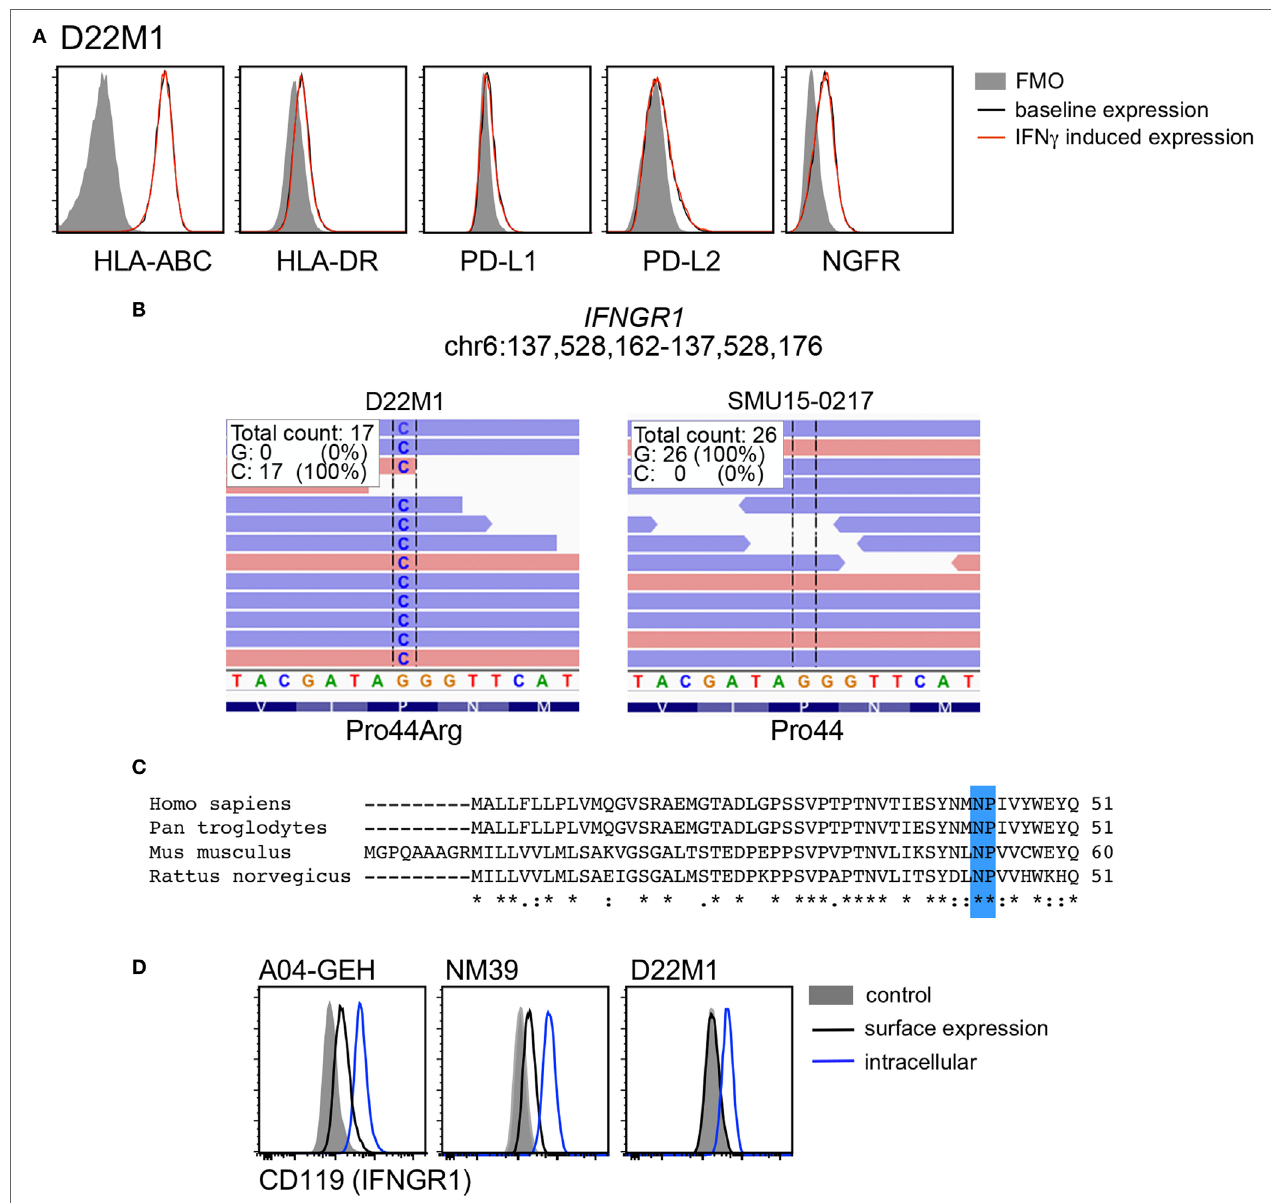
FigUre 6 | Analysis of interferon gamma receptor 1 (IFNGR1) expression in the D22M1 cell line. (a) Representative histograms of cell surface expression of HLA-ABC, HLA-DR, PD-L1, PD-L2, and nerve growth factor receptor (NGFR) on D22M1 cells. Baseline expression is shown in black, interferon- γ (IFN γ )-induced expression in red, and fluorescence minus one (FMO) controls as shaded histograms. (B) Whole exome sequencing analysis showing Pro44Arg (P44R) substitution in the D22M1 cell line but not in the SMU15-0217 cells. (c) Alignment of IFNGR1 protein sequence of human, chimpanzee, mouse, and rat (Clustal Omega) showing the highly conserved NP linker region highlighted in blue. (D) Expression of IFNGR1 on the cell surface (black) and intracellularly (blue) in A04-GEH, NM39, and D22M1 cells, with mean fluorescence intensity values also shown. Shaded histograms represent the mock stained